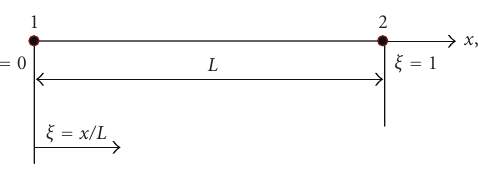
Figure 6: Beam element with two nodes.